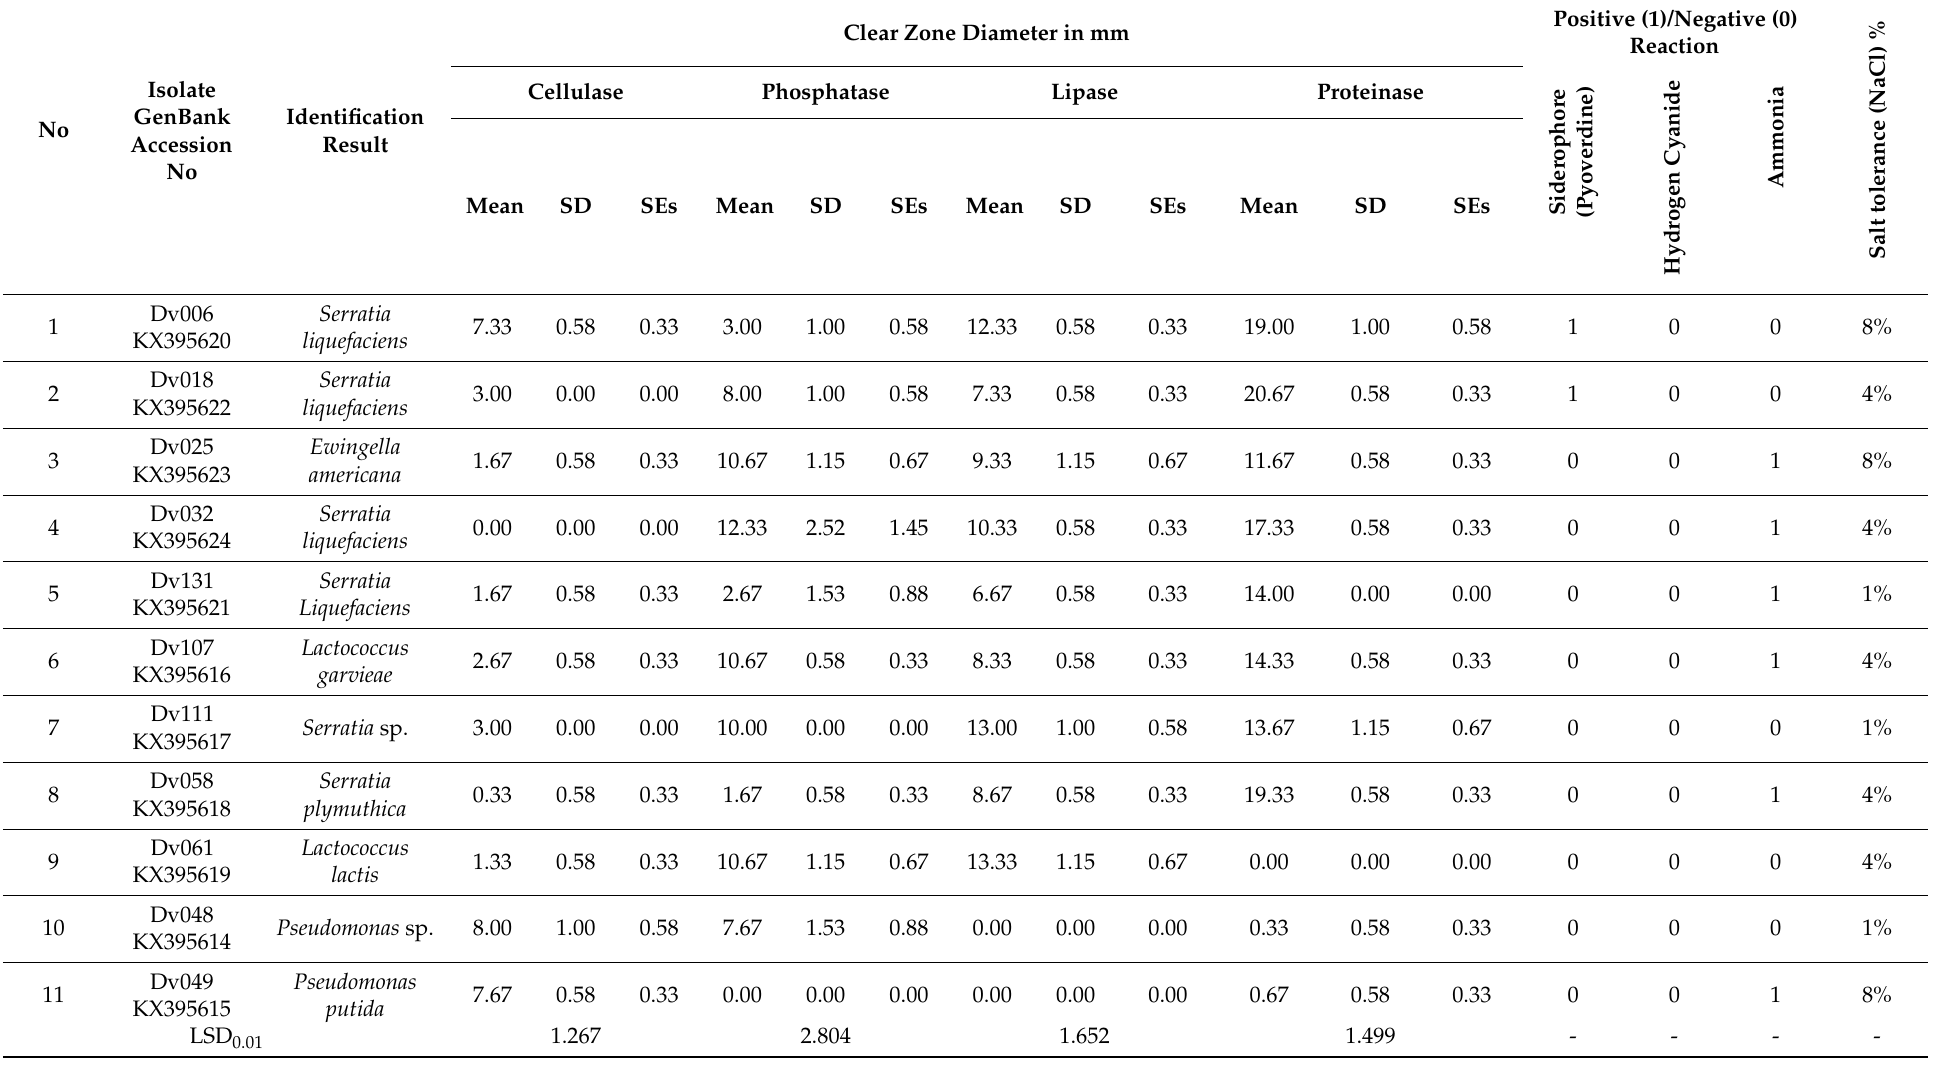
Table 1. Summary of the biochemical characterization of the isolates selected for the tested bacterial consortium. Diameters data are the mean of three